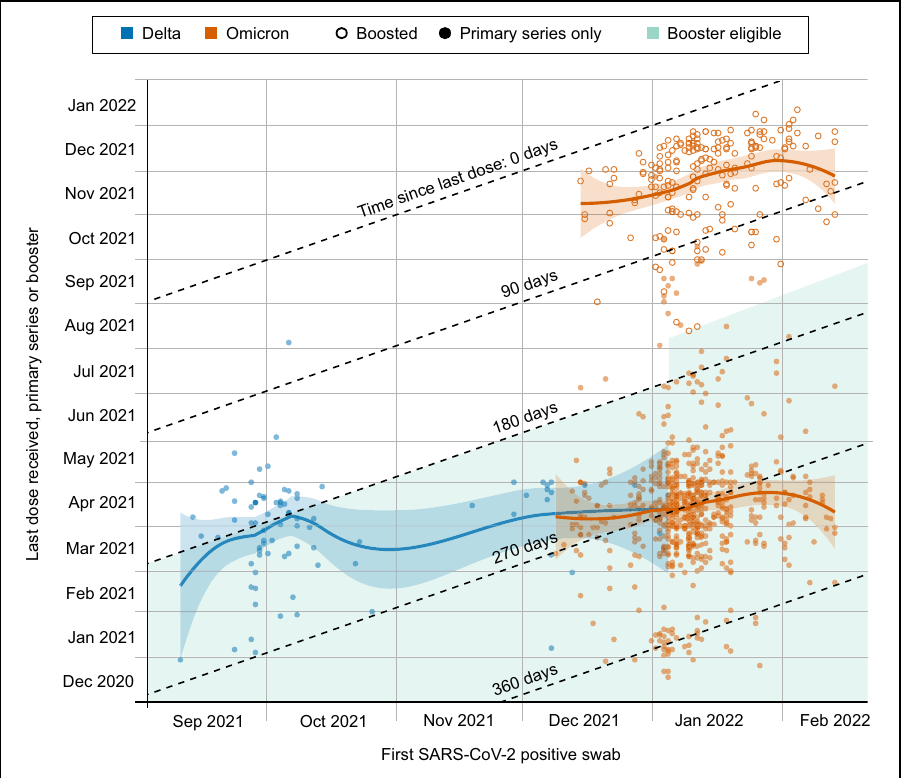
Fig. 2 | Interval between Delta or Omicron infection and last mRNA vaccine dosereceived. Local fi tted polynomialregression using the loessfunctionof theR stats package, with α =0.75 and second-degree polynomials is shown as shaded 95% CIs shown for each variant and by booster status for Omicron. Period of boostereligibilityis180or150days(beginningJanuary4,2022)afterprimaryseries